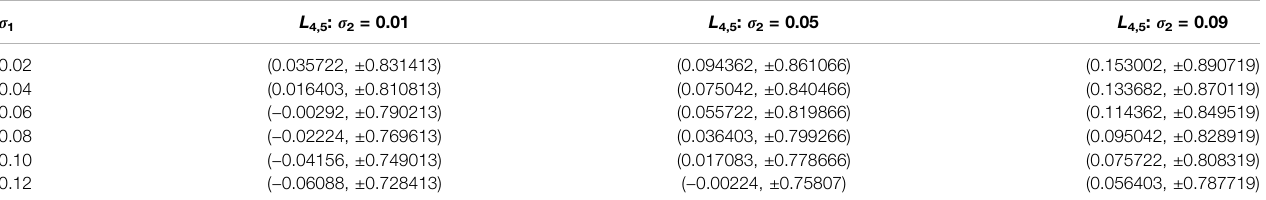
TABLE 9 | Positions ( x 0 , ± y 0 ) of the two triangular points L 4 and L 5 of the binary HD155876 system for three fi xed values of σ 2 when σ 1 varies. The radiation pressure, oblateness, mass of the disc, and triaxiality parameters of the smaller primary are kept as constants as in the collinear case (Table 8) . σ L σ 1 4,5 : 2 =